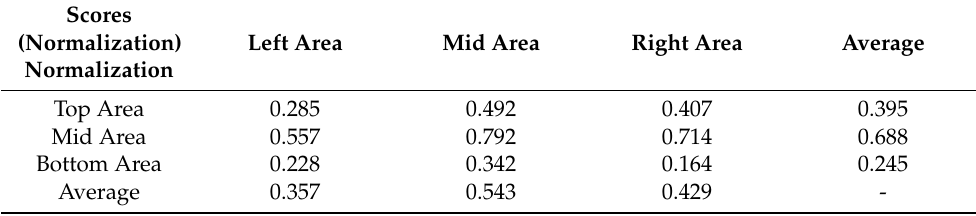
Table 3. Scores of subjective